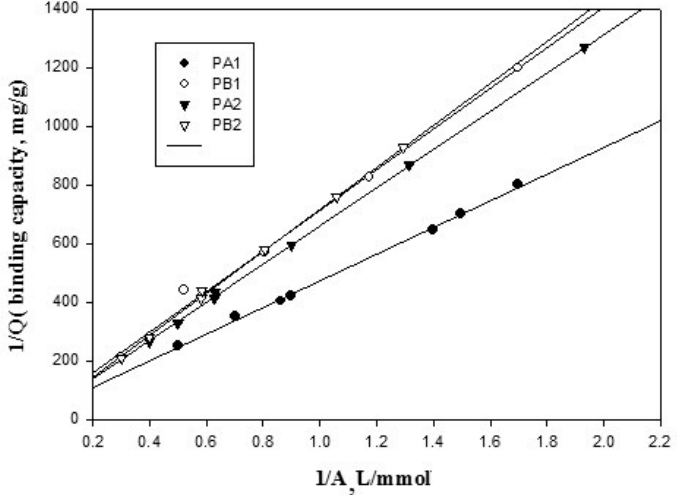
Figure 4 . Langmuir plots to estimate the binding parameters of